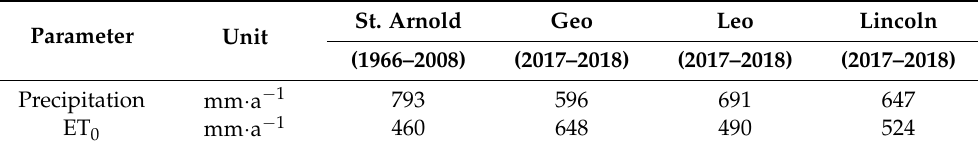
Table 1. Mean annual totals for precipitation and ET 0 of the locations under consideration. The years in brackets indicate the analyzed